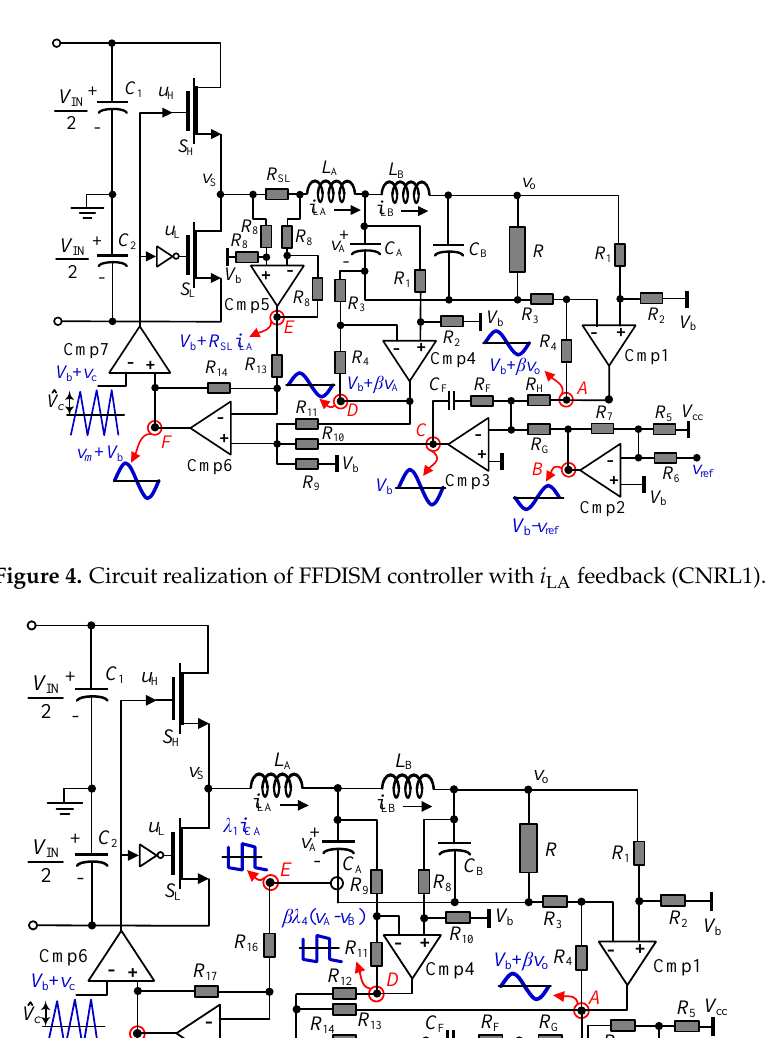
( b ) Figure 6. Prototype of GaN class-D amplifier ( a ) top-side ( b ) bottom side. 5. Results and Discussion In this section, the performance of the proposed FFDISM controller is evaluated using simulation and experimental results. First, the frequency response and step response of the closed-loop system based on control diagram reduction are presented. This fundamental technique is useful to investigate the effect of the inner-loop on the compensation of resonance. Furthermore, computer– based circuit simulator i.e., Plexim Plecs is used to analyze the transient behavior of class-D amplifier using different resistive loads. Finally, experimental results are presented for validation of FFDISM controller.